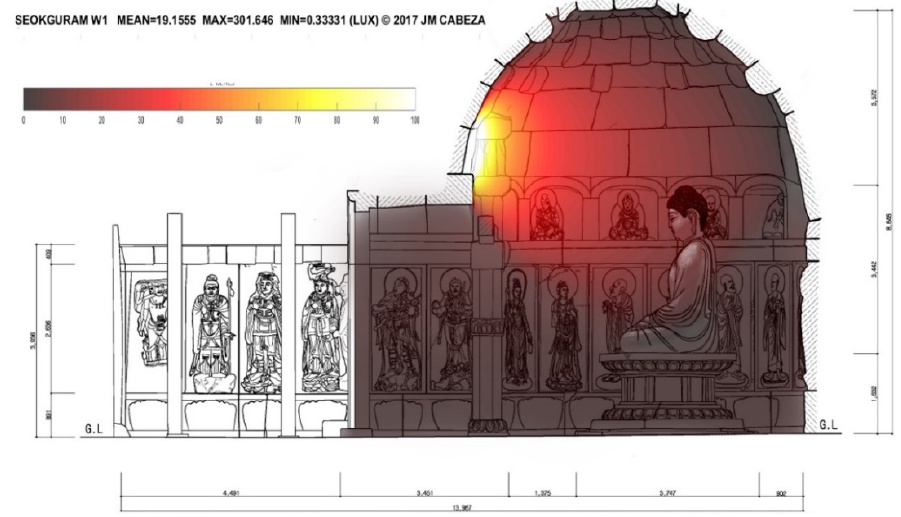
Figure 29. Sectional view of the grotto including simulation of lighting levels by a surmised circular opening oriented to the east.